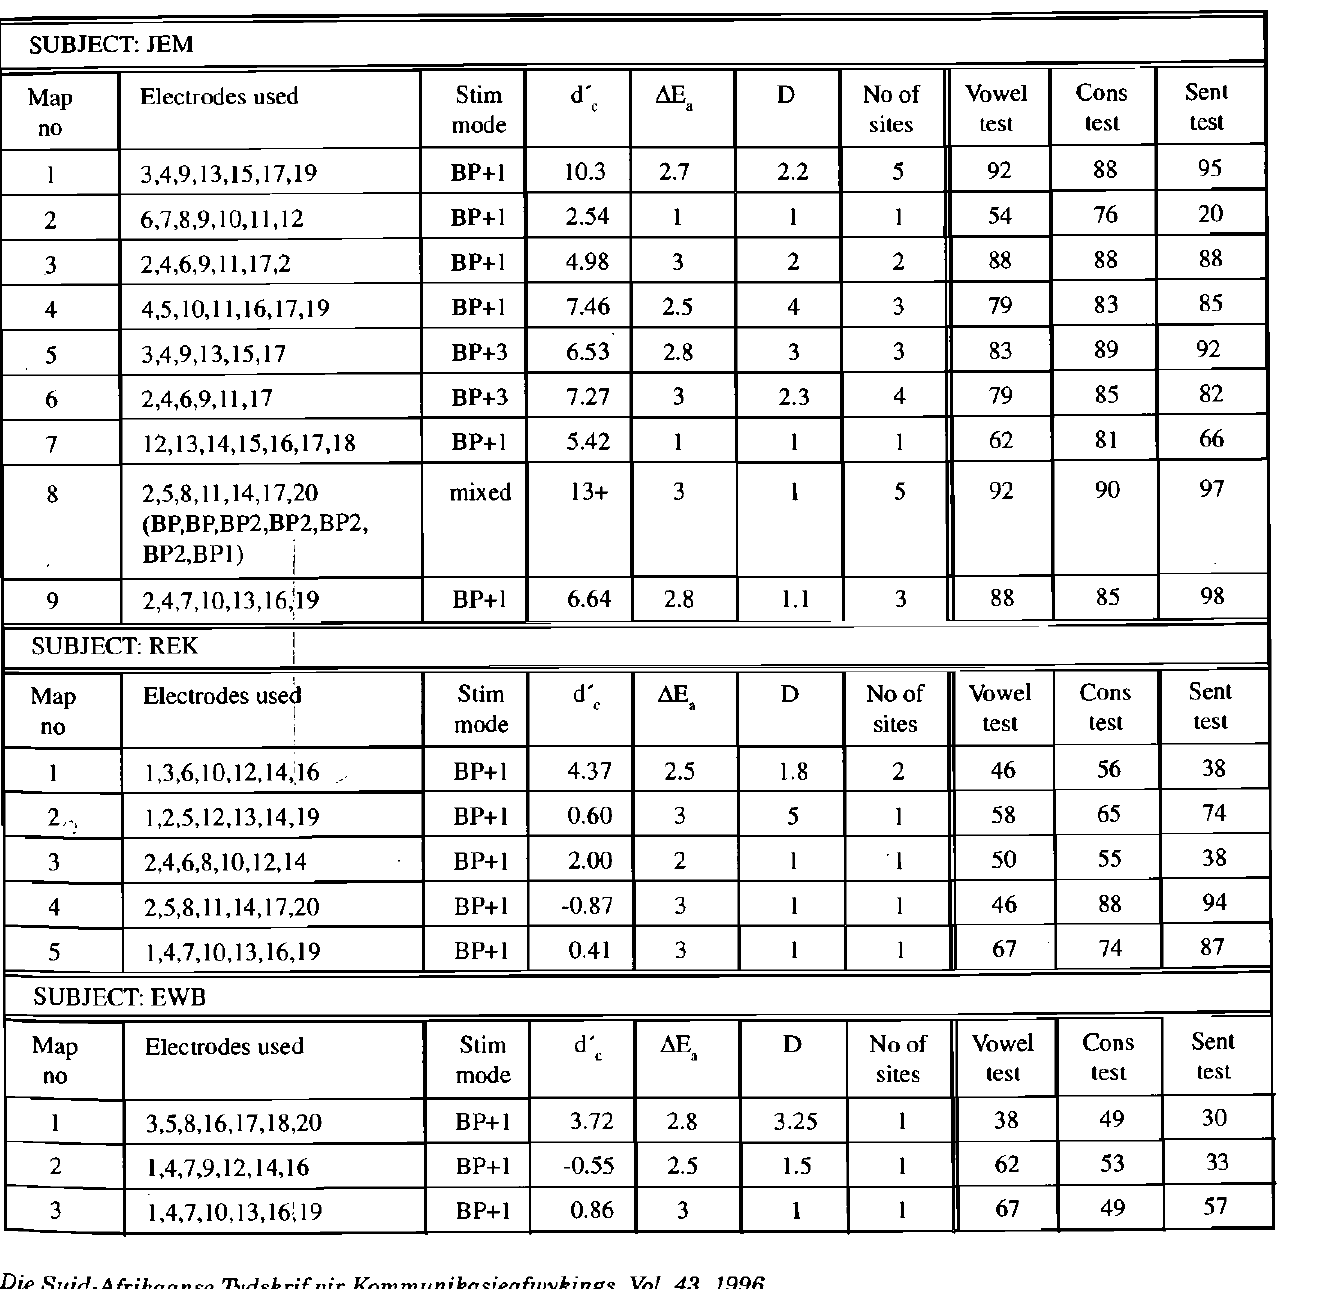
TABLE 2. Results for the speech perception experiment. The number/) is a simple measure for the disorder in electrode spacing as calculated by equation 1. ΔΕ λ is the average spacing between electrodes. d' c is the cumulative d'. No of sites refer to the number of discrete stimulation sites when d' > 1.5 is used as criterion. Cons and Sent are abbreviations of Consonant and Sentence, respectively. The table lists the stimulation modes used for each electrode for the mixed stimulation mode map for JEM (map 8). The abbreviations BP1 and BP2 are used for BP+1 and BP+2 stimulation modes,